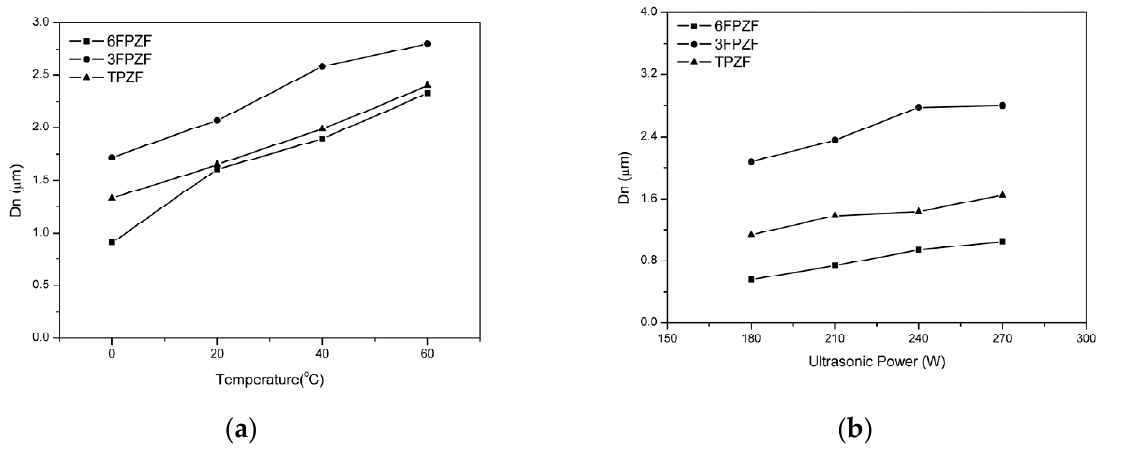
Figure 6. ( a ) Dependence of number–average particle size (Dn) of polymer microspheres on tem- perature of the 6FPZF, 3FPZF and TPZF microspheres; ( b ) effect of ultrasonic power on num- ber-average particle size (Dn ) of the 6FPZF, 3FPZF and TPZF microspheres.